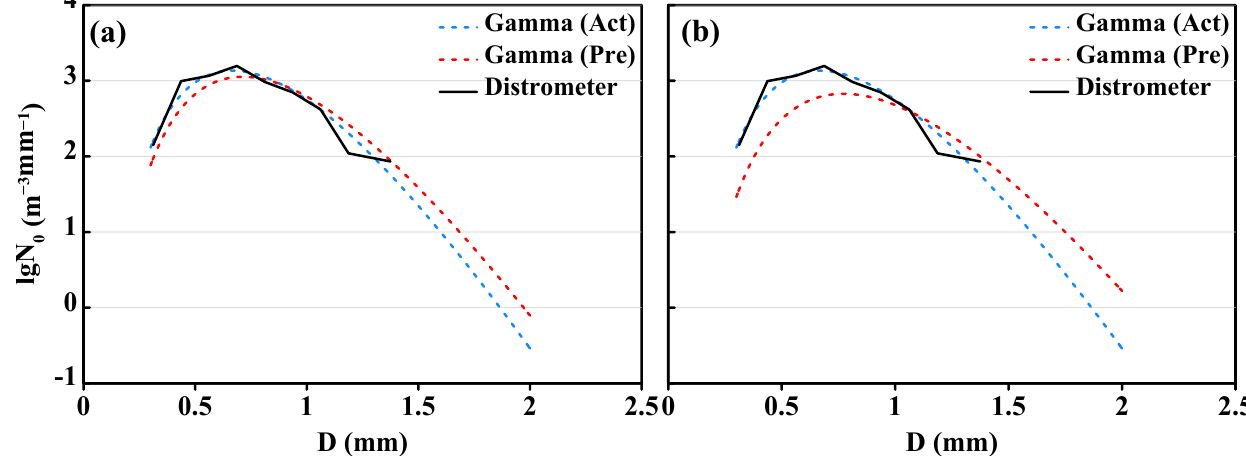
Figure 11. The DSDs of measurement (black solid line), Gamma fitting (blue dotted line), and model prediction (red dotted line, ( a ) 12-min and ( b ) 30-min prediction) at the 1063th min of this stratiform cloud precipitation case.